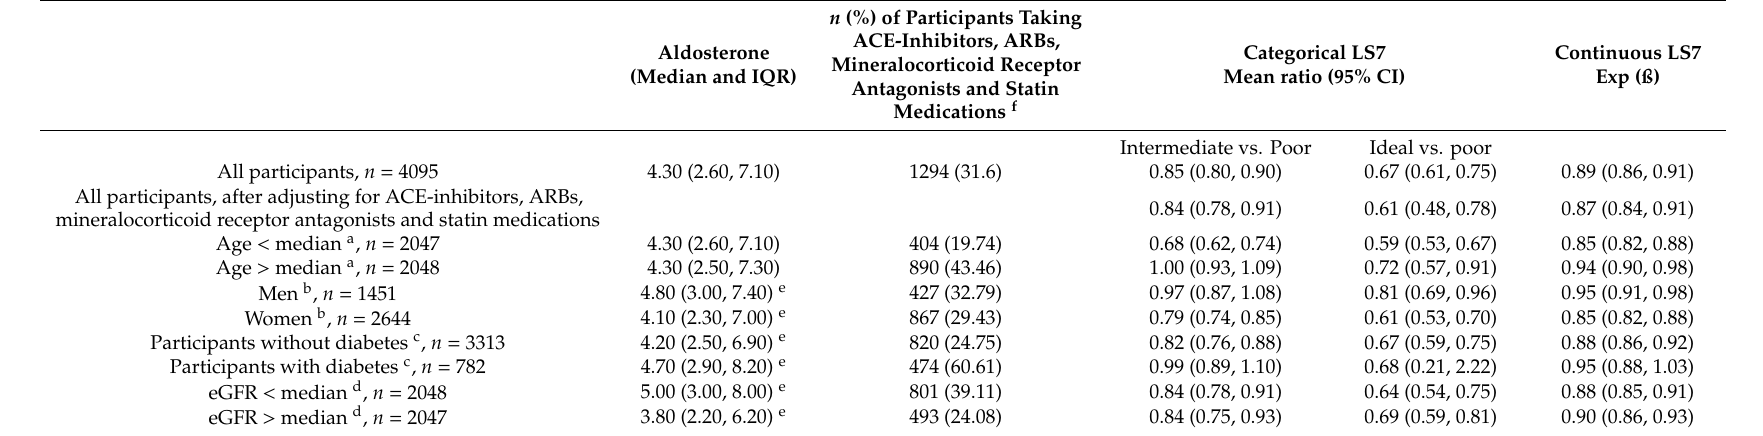
Table 2. The association of categorical and continuous LS7 scores with aldosterone among all participants and stratified by age, sex, diabetes status, estimated Glomerular Filtration Rate